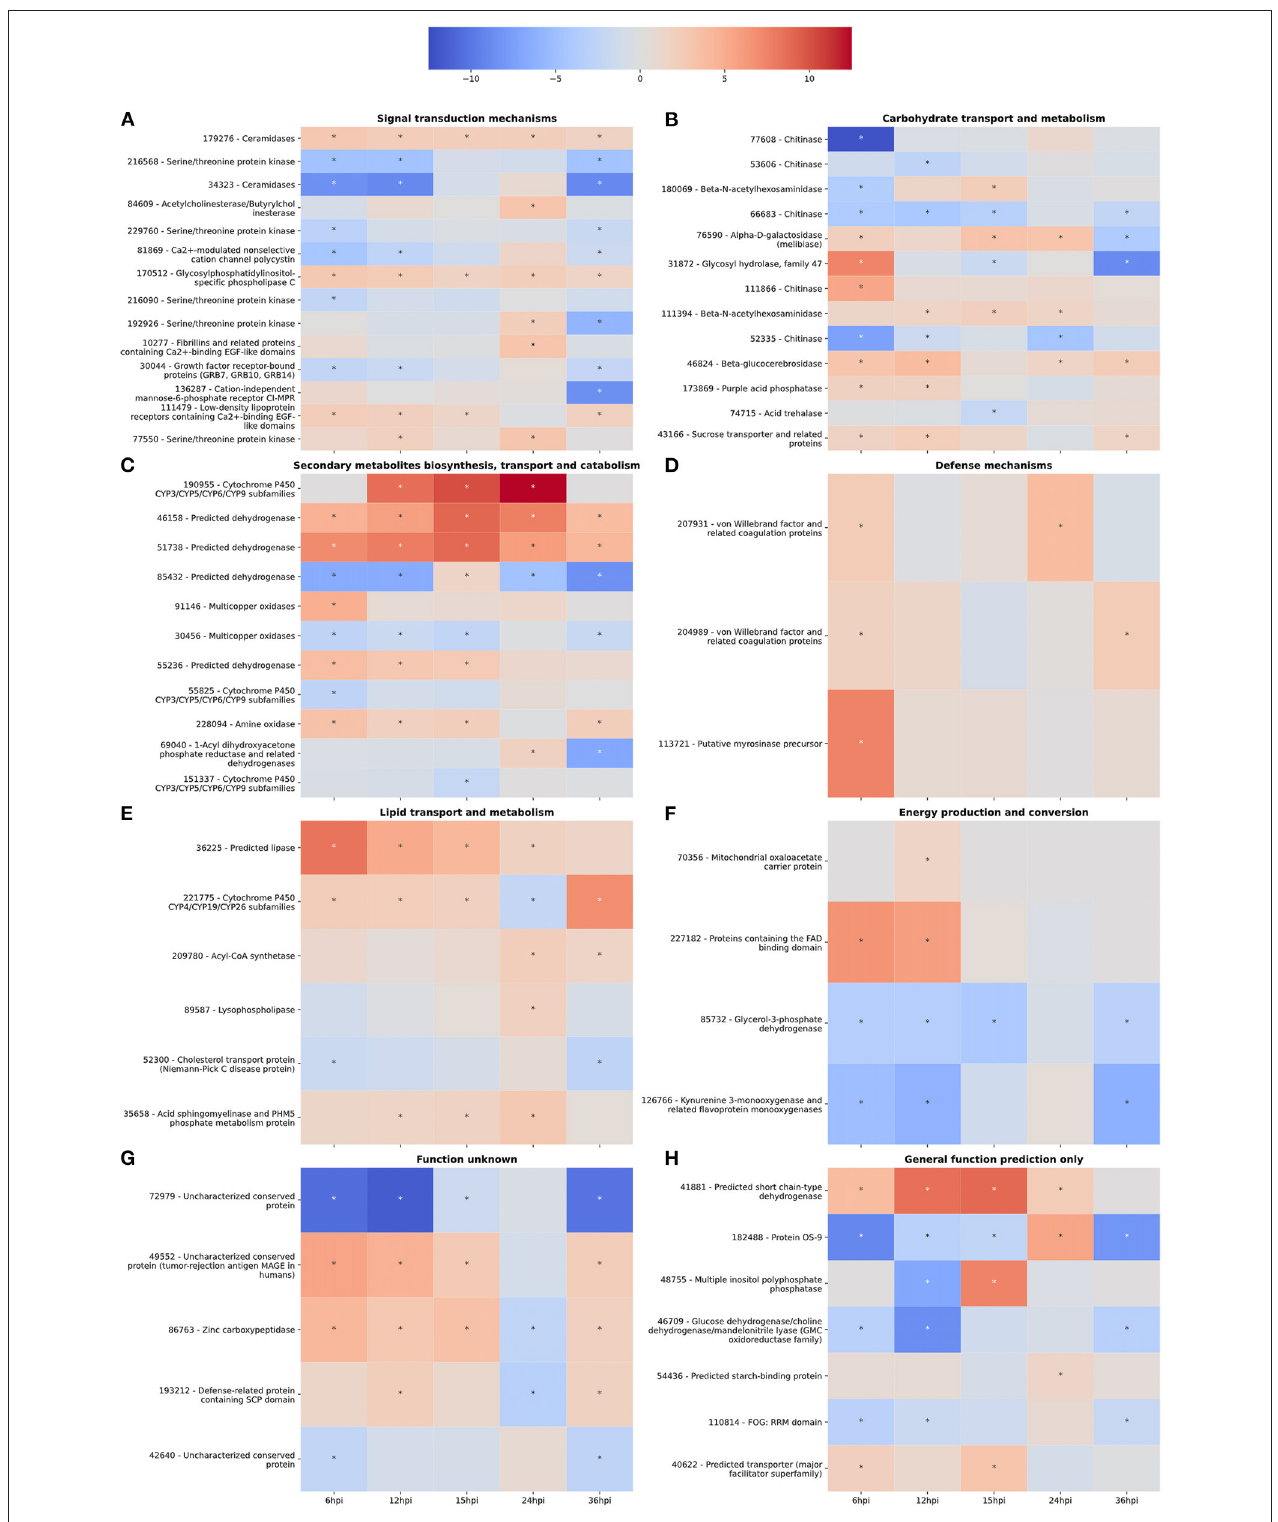
FIGURE 2 | (A–H) Gene expression heatmaps of T. virens secreted proteins belonging to selected KOGG classes. KOGG classes were chosen based on potential involvement in the colonization process. The color scale of blue to red represents a range of − 12.5 to 12.5 log2-fold change compared to the fungus cultivated alone at each corresponding time point. Asterisks denote an absolute value log2-fold change > 1.5 and a false-discovery rate < 0.05 as calculated during differential expression analysis in EdgeR.